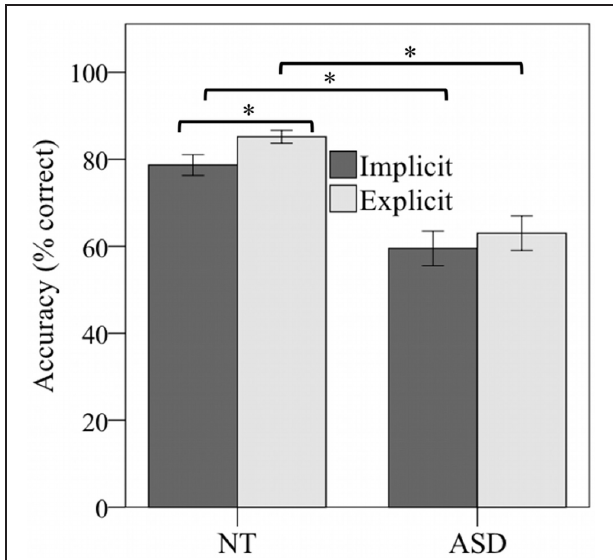
FIGURE 2 | Accuracy scores (percentage of correct responses) by TASK (implicit vs. explicit) and GROUP (ASD vs. NT). Whereas there was no significant difference between implicit and explicit task accuracy in the ASD group, typically developed participants’ accuracy was significantly increased in the explicit task. The NT group showed increased accuracy in both tasks as compared to the ASD group. ∗ p < 0 . 05.